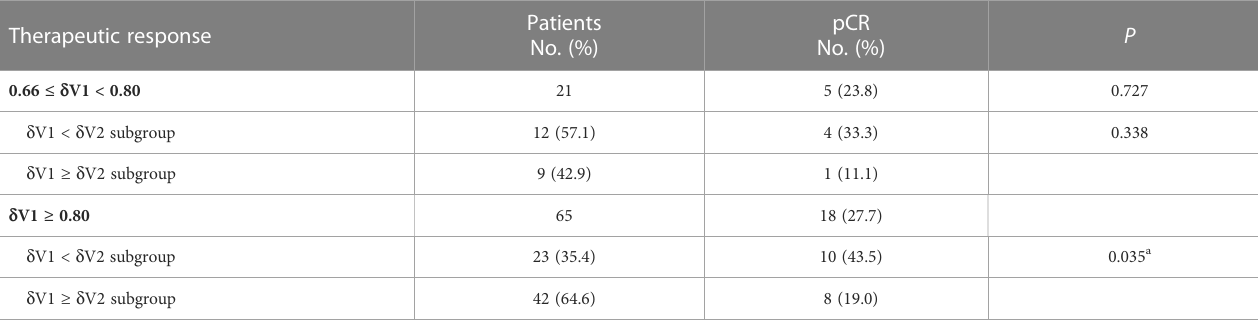
TABLE 4 Higher pCR rates were observed in the d V1 < d V2 subgroup of the d V1 ≥ 0.80 subpopulation. Therapeutic response